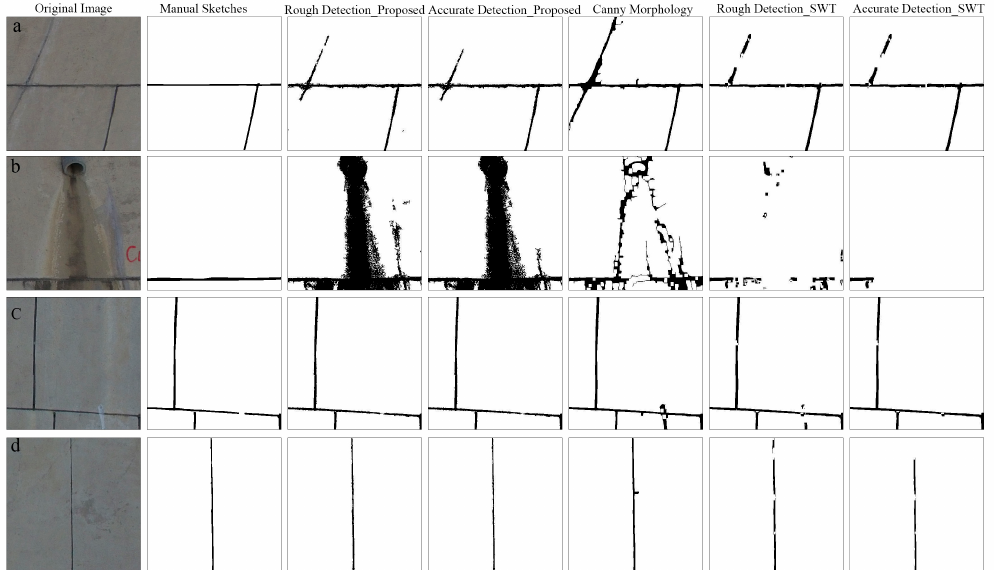
Figure 12. Four typical partial examples of expansion joint detection. Columns from left to right are the original images, manually drawn sketches, rough detection results using the proposed